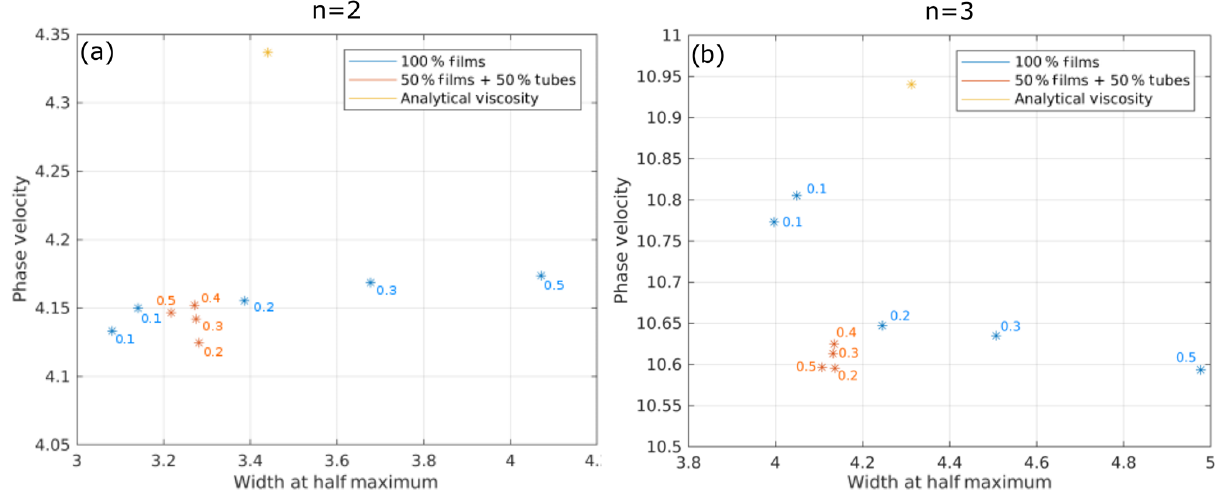
Figure 6. Non-dimensional half width plotted against non-dimensional phase velocity for a porosity wave of amplitude 8 for different viscosity laws. The numbers give the aspect ratios of the films or melt pockets. The background porosity is 0.5%. (a) Permeability–porosity exponent n = 2 and (b) n = 3.